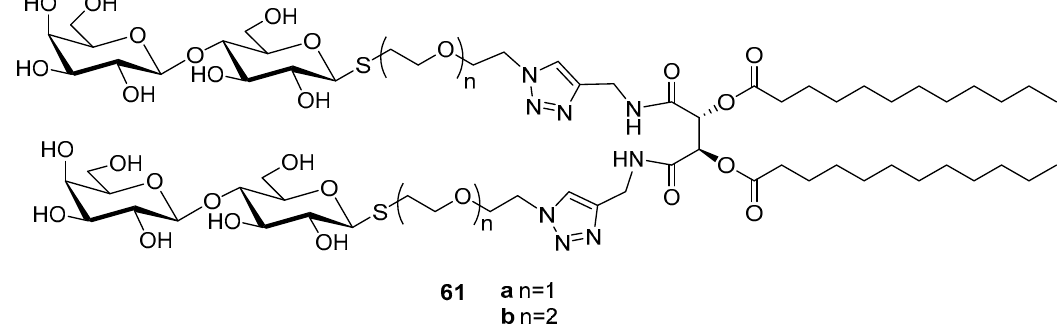
Figure 40. Structures of thiolactose-based amphiphilic gelators [86], n is the number of repeating unit.